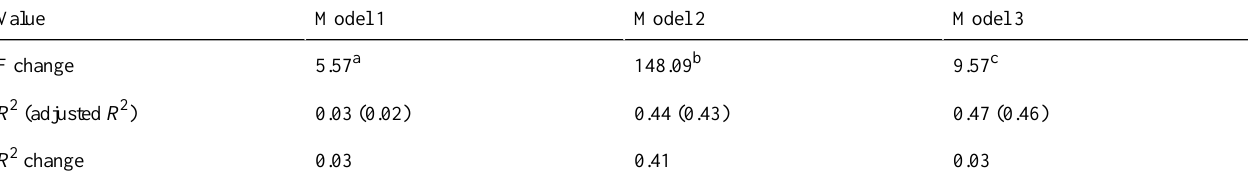
Table 5. F and R values of the statistical analysis predicting state anxiety from gender, daily functional self-actualization, and functional